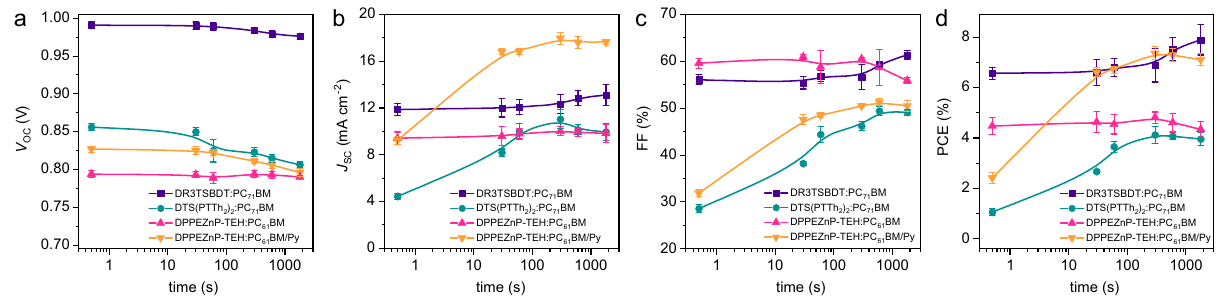
Fig. 8 Device performance change. Change of a V OC , b J SC , c FF, and d PCE of DR3TSBDT:PC 71 BM, DTS(PTTh 2 ) 2 :PC 71 BM, DPPEZnP-TEH:PC 61 BM and DPPEZnP-TEH:PC 61 BM/Py under different thermal annealing time (error bars represent the standard deviation over ten devices).